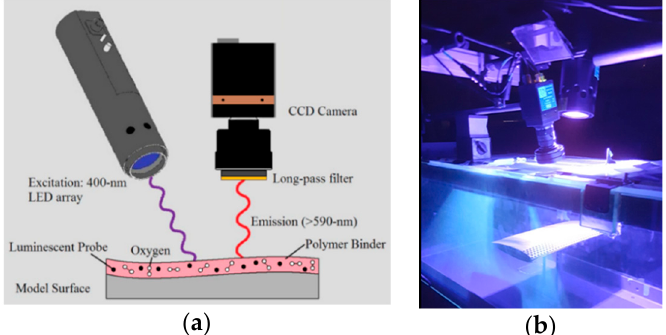
Figure 4. Temperature sensitive paint (TSP) schematic (ISSI Inc.), reproduced from [21]. ( a ) and current North Dakota State University (NDSU) Advanced Flow Measurements Laboratory setup photography ( b ).